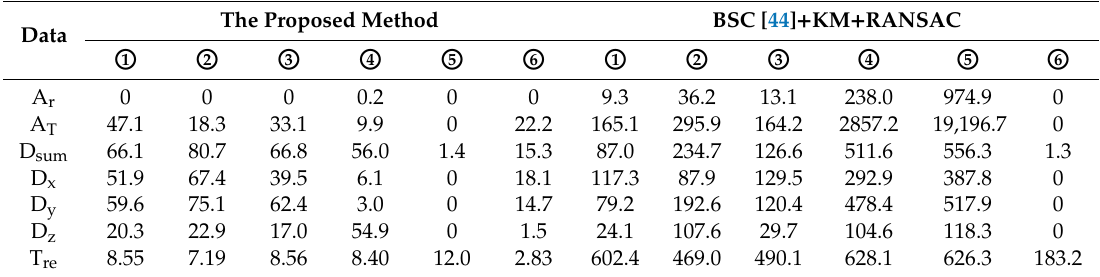
Table 6. Evaluations of above registration results